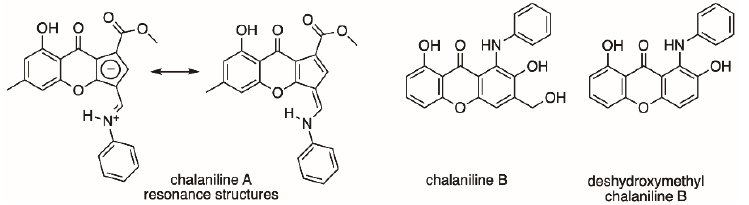
Figure 1. Chalanilines A and B isolated from Chalara sp. and deshydroxymethyl chalaniline B made by chemical synthesis.